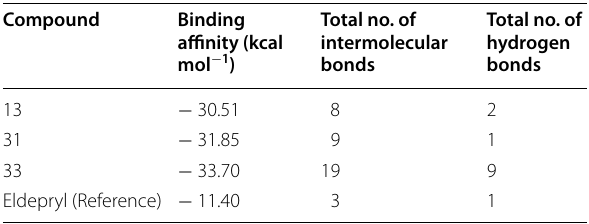
Table 6 Virtual screening of the compounds docked against